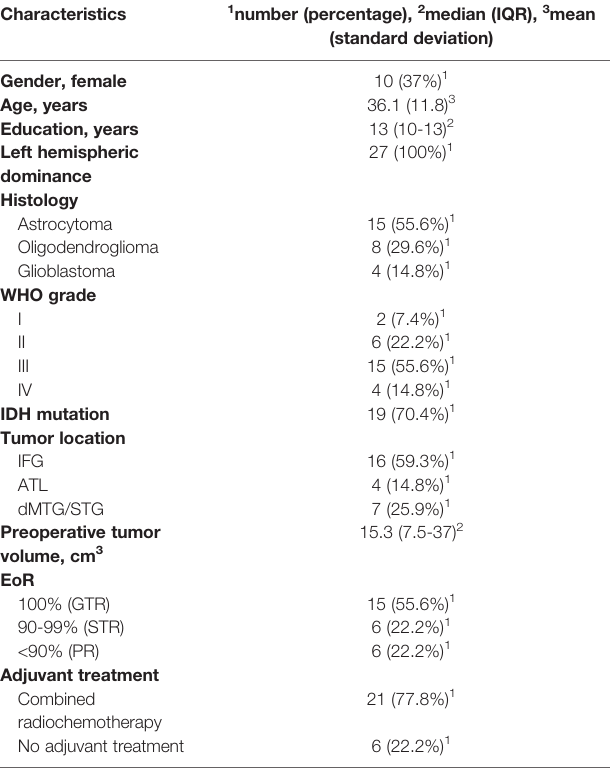
TABLE 2 | Demographic